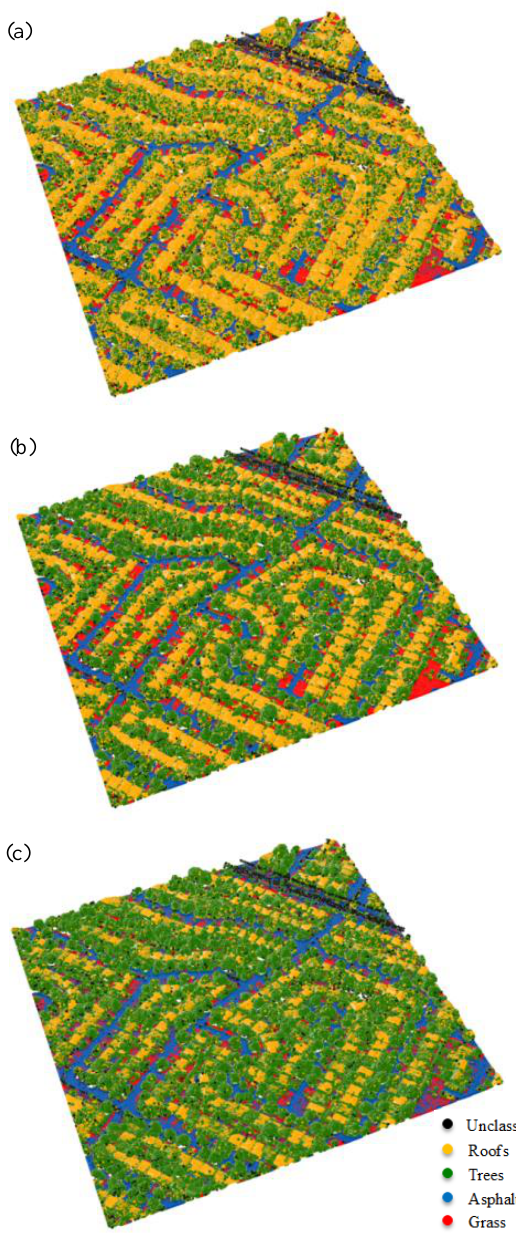
Figure 7. Classified LiDAR points based on a) NDVI C2-C1 , b)